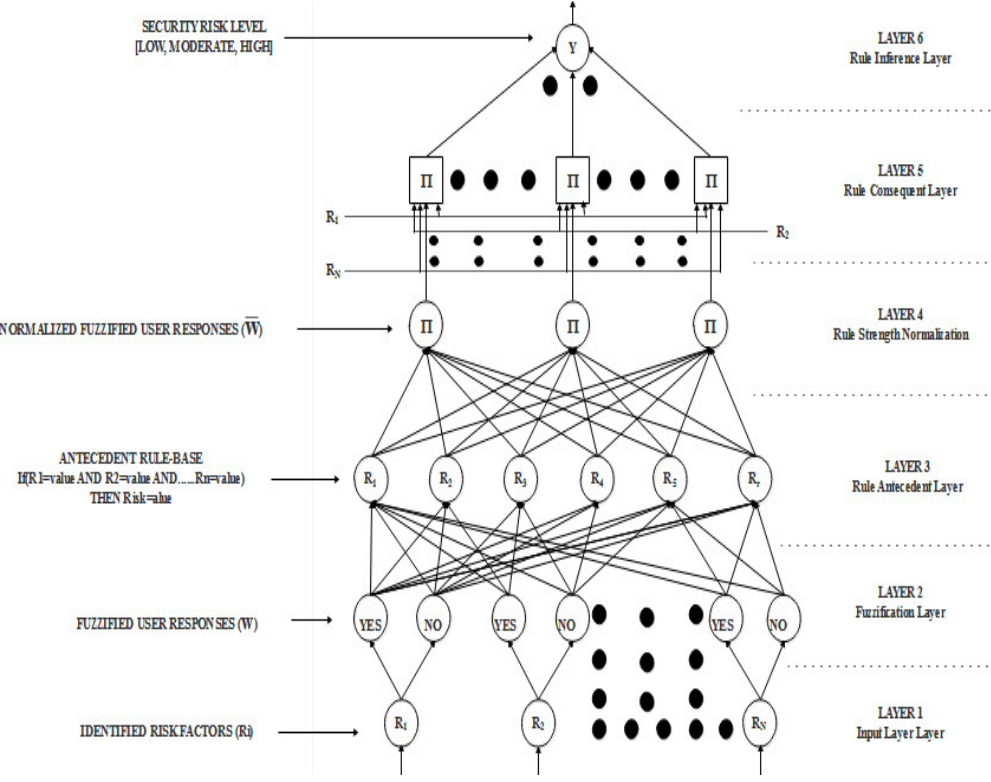
Figure 5. The proposed framework for SRA in software development stages.